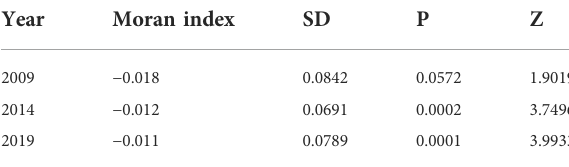
TABLE 2 Global moran index of CAA competitiveness in the